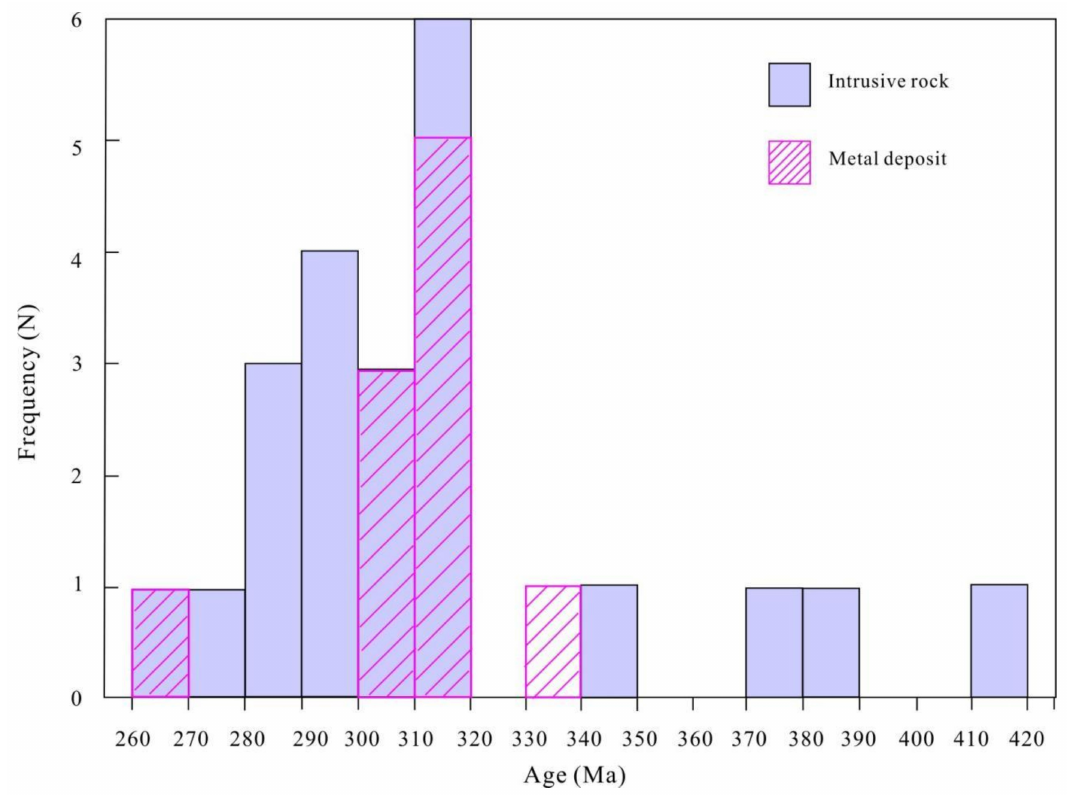
Figure 8. Age histogram of the typical intrusive rocks and some important metal deposits in the Kalamaili